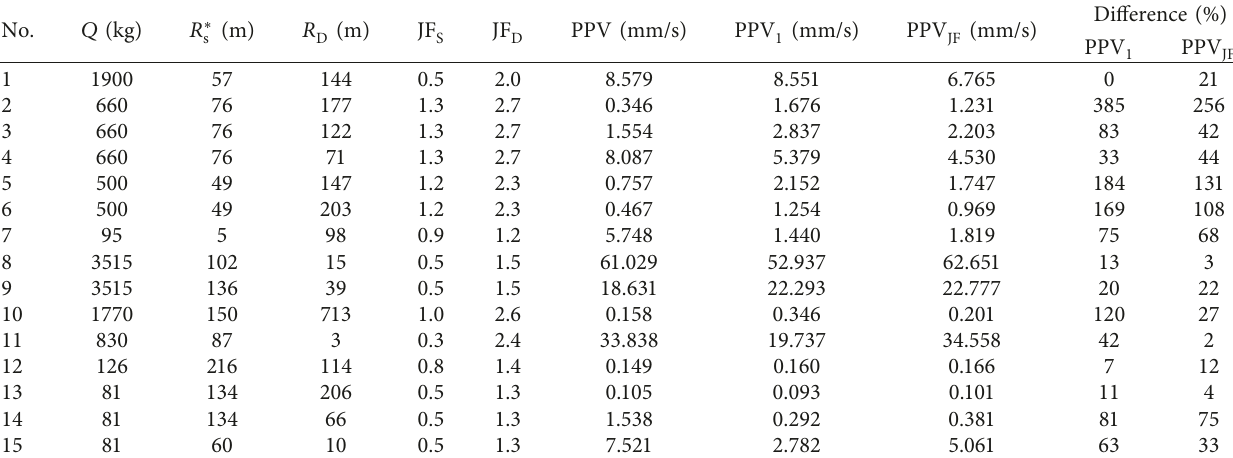
Figure 12: Schematic diagram of lithology changes between blasting area and monitoring Table 6: The blasting vibration data at bench of different rock properties.